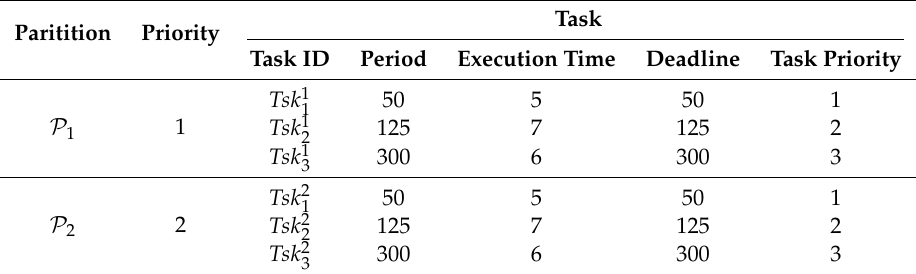
Table 3. IMA task set of Experiment 1.